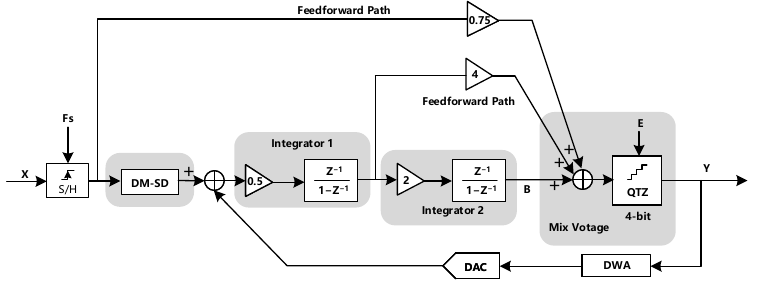
Figure 1. Block diagram of the proposed second-order feed-forward Σ∆ modulator.